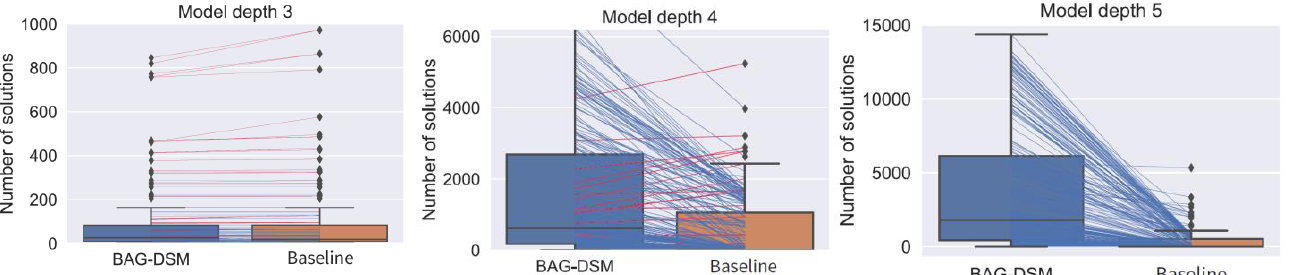
Figure 13. Paired boxplots for the size of the solution set (bigger is better) generated by BAG-DSM vs. baseline for decision support models with a depth of 3, 4, and 5. The horizontal lines connect two experimental runs with the same experimental setup. The red horizontal lines represent the experimental setups in which the baseline performed better.